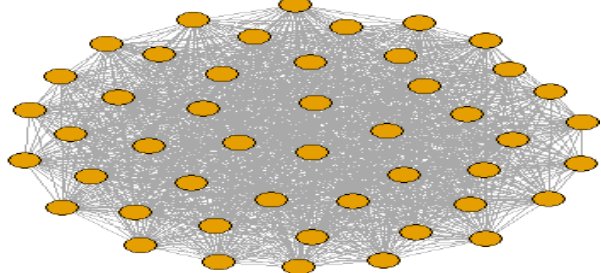
Figure 1: A Network Model (Source: Authors ‟